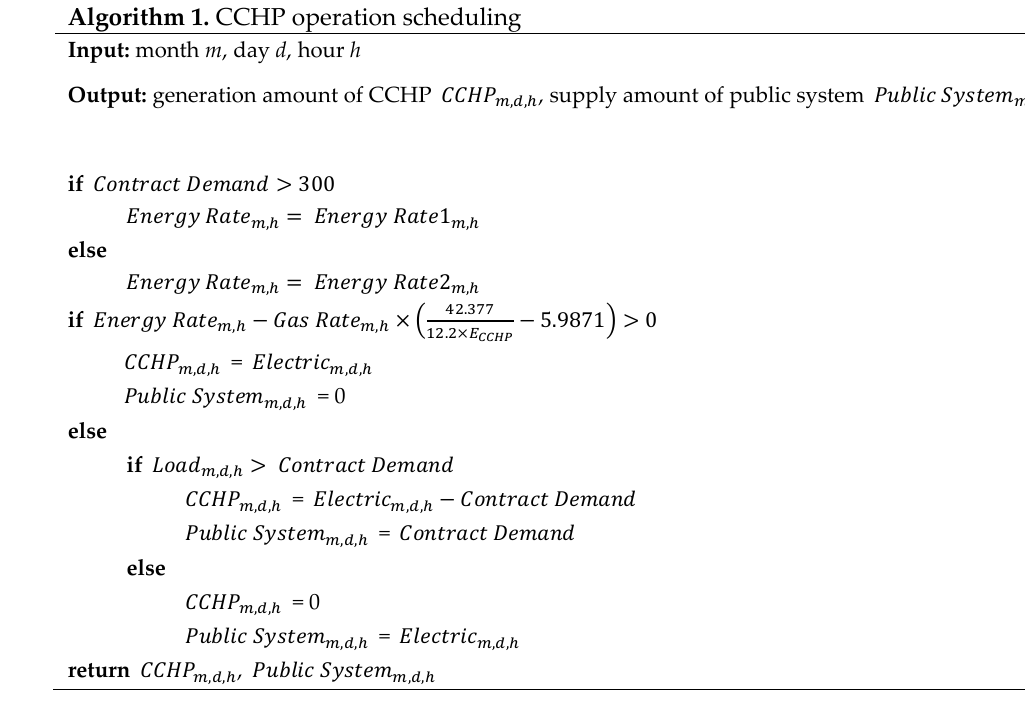
Algorithm 1. CCHP operation